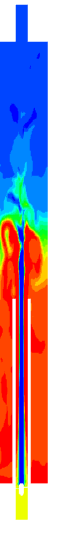
Figure 8. Separator internal liquid phase distribution.